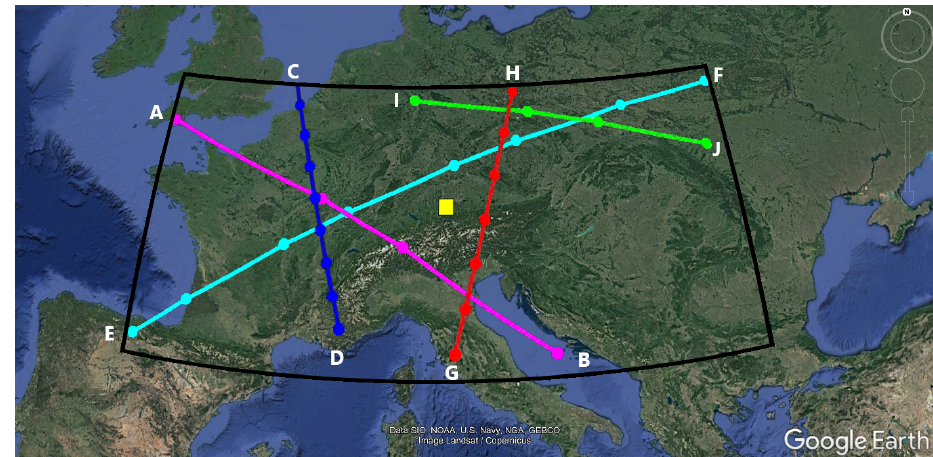
Figure 1. The area defined for coincident measurements during the HOPS campaign (42.8, − 4 . 0–52.8, 26.0). The Hohenpeißenberg Me- teorological Observatory is represented by the yellow square at (47.8, 11.0), and the nearby Munich–Oberschleißheim radiosonde launches are located at (48.1, 11.3). For the night beginning on 29 March 2019, the HOH lidar operated from 21:28–04:40UTC; the MLS overpass (G–H, red) occurred at approximately 01:14UTC on 30 March; the SABER overpasses occurred on 29 March at 22:45UTC (E–F, cyan) and 23:30UTC (A–B, magenta), and on 30 March at 01:16UTC (I–J, green); and the OMPS overpass (C–D, blue) occurred on 30 March at 11:50UTC (data: ©Google Earth Pro,